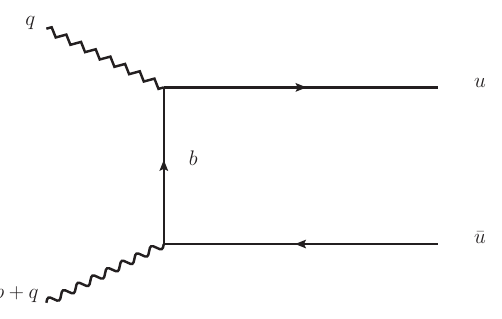
Figure 1 . Diagrammatical representation of the leading-order (LO) contribution to the QCD amplitude F (cid:22) ( p; q ) de(cid:12)ned in